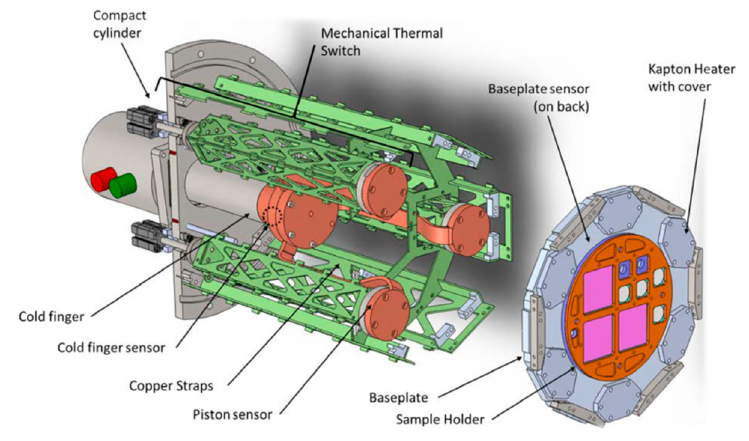
Figure 14. Thermal vacuum cycle mechanical CAD design.